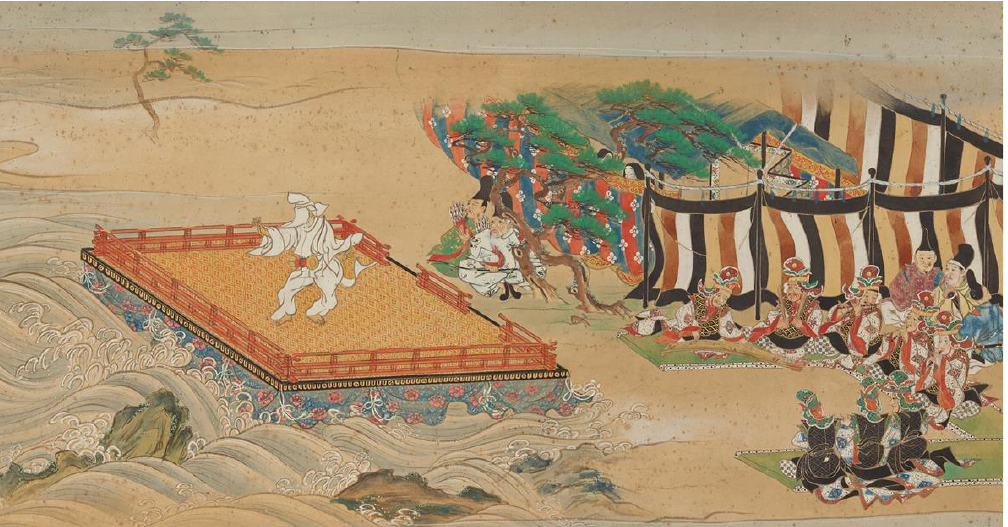
Figure 7. Hakozaki Hachimangū engi 筥崎八幡宮縁起 (The story of Hakozaki Hachiman Shrine, 1672). Hakozaki Hachiman Shrine, Fukuoka (Fukuoka prefecture). Courtesy of the Hachiman Pro- ject, University of Heidelberg. At https://kjc-sv038.kjc.uni-heidelberg.de/hachiman/#O4640.6/, ac- cessed on 15 June 2022.